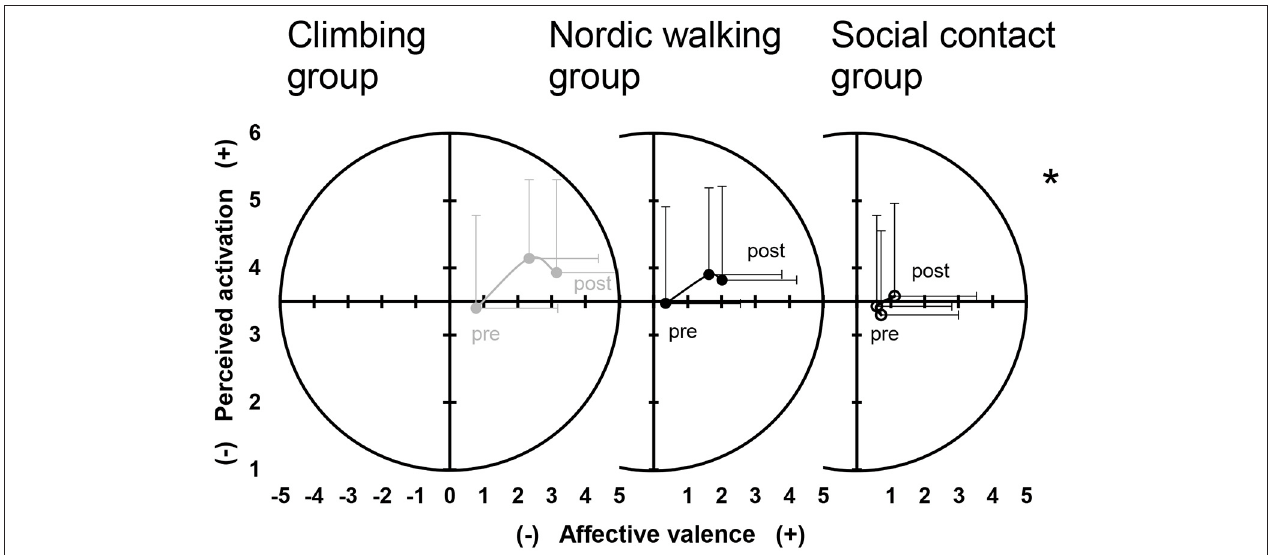
FIGURE 3 | Dimensional affective responses, affective valence, and perceived activation over time separated by climbing group (left panel, filled gray circles), nordic walking group (middle panel, filled black circles), and social contact group (right panel, empty black circles). Circles represent mean values and error bars indicate standard deviations. *Indicates a significant time-by-group interaction both for affective valence and perceived activation.